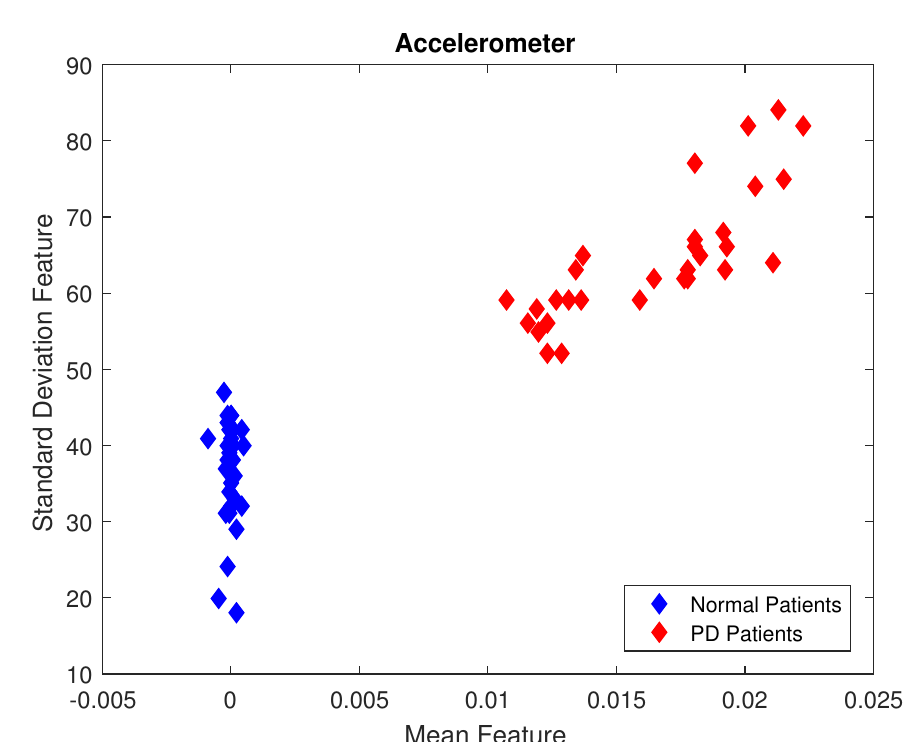
Figure 9. Two-dimensional scatter plot of the standard deviation feature vs. the mean feature of wrist accelerometer sensor for normal and PD